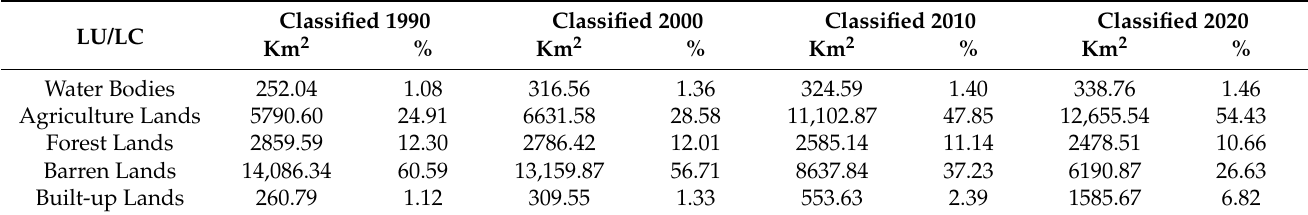
Table 3. Historical LU/LC composition in the Plateau.